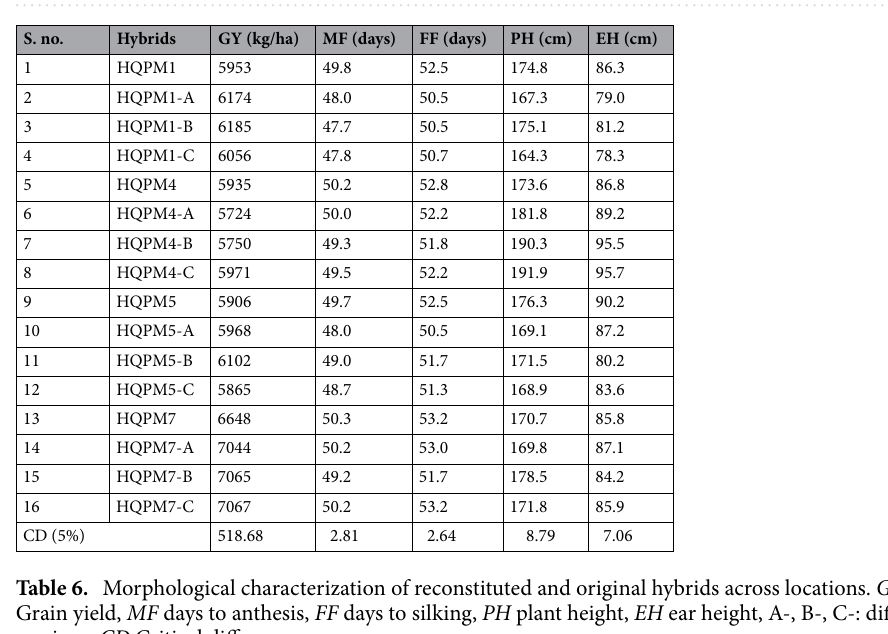
Figure 7. Tryptophan concentration in original- and reconstituted waxy-hybrids.